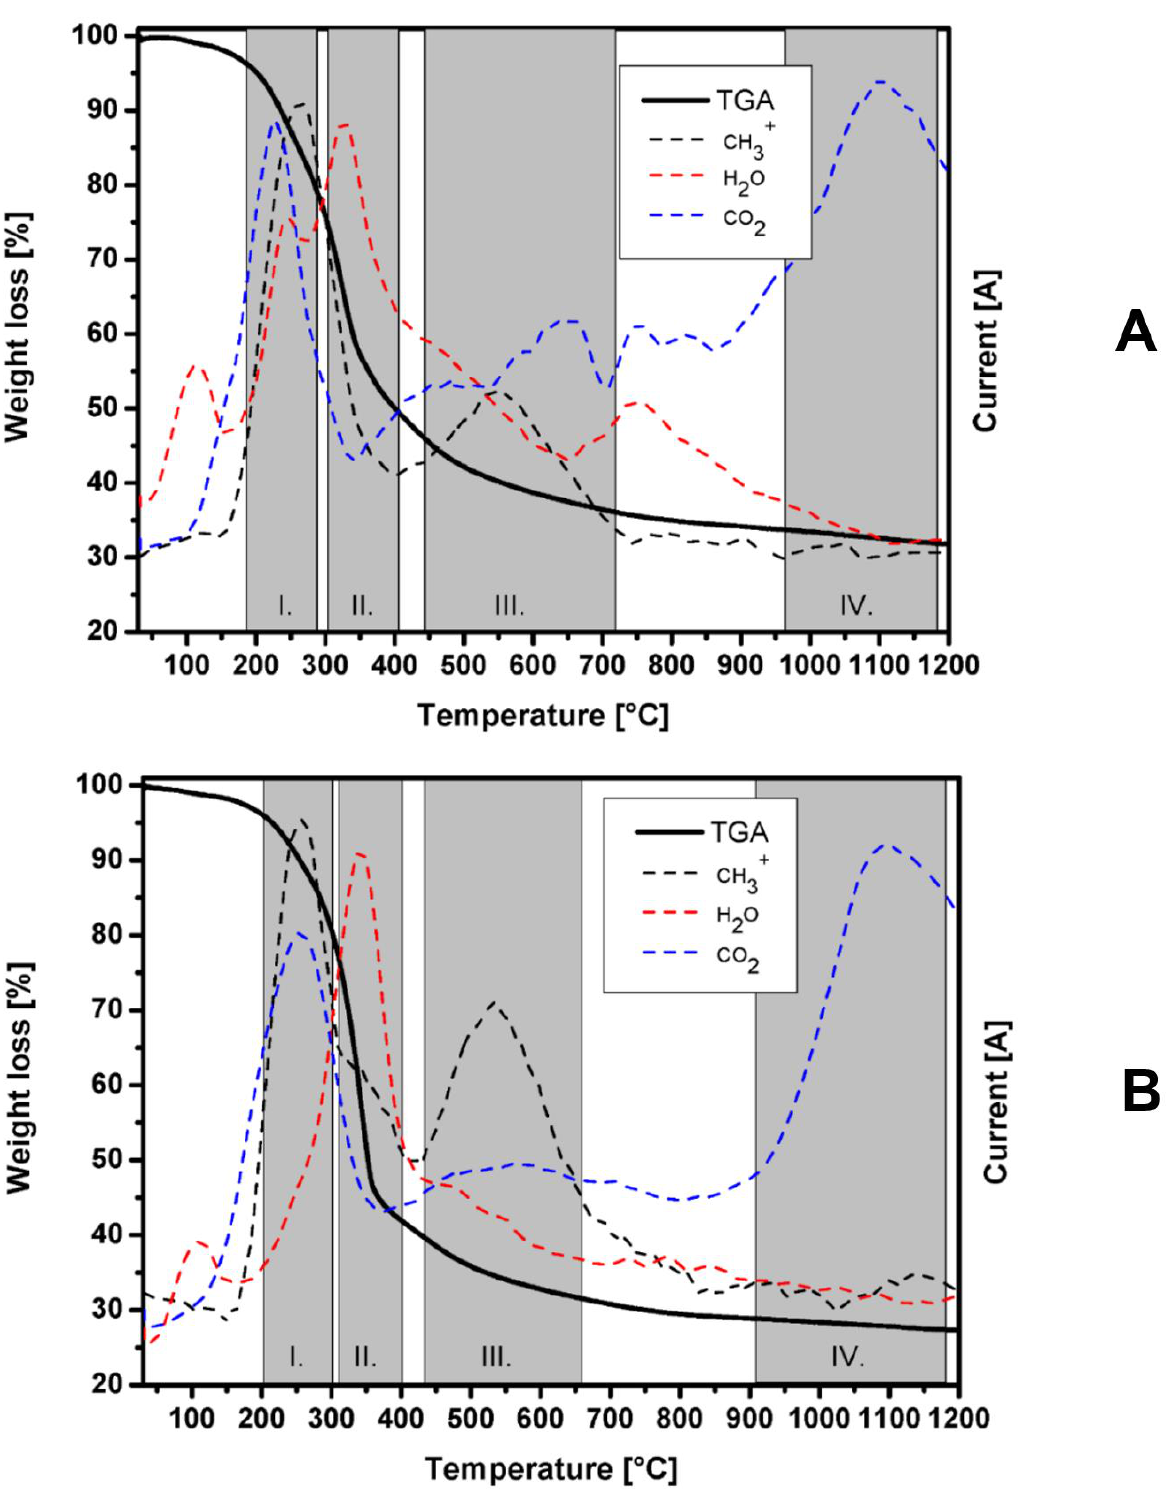
Figure 3. Evolved gas analysis of polyenaminone 4aa ( A ) and polyenaminone 4ba ( B ). Different colors represent fragments with m/z that correspond to methyl (CH 3 + ), water and CO 2 signals. Black curves represent the TGA profiles of polyenaminones 4aa and 4ba . Gray rectangles represent region I, region II, region III, and region IV respectively.